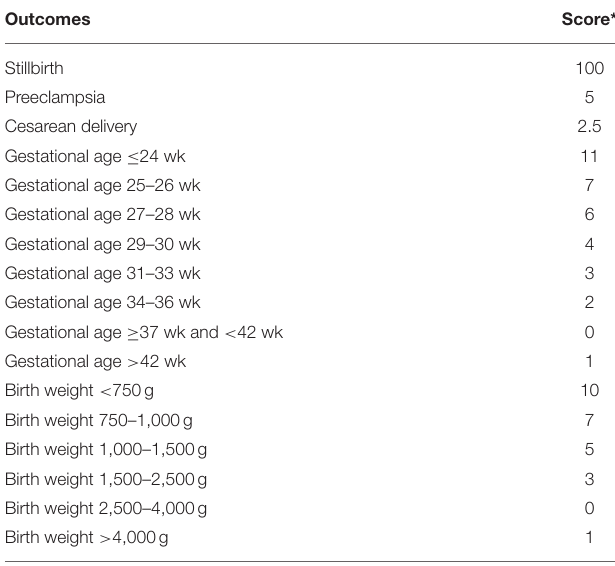
TABLE 1 | Maternal-birth outcomes scoring